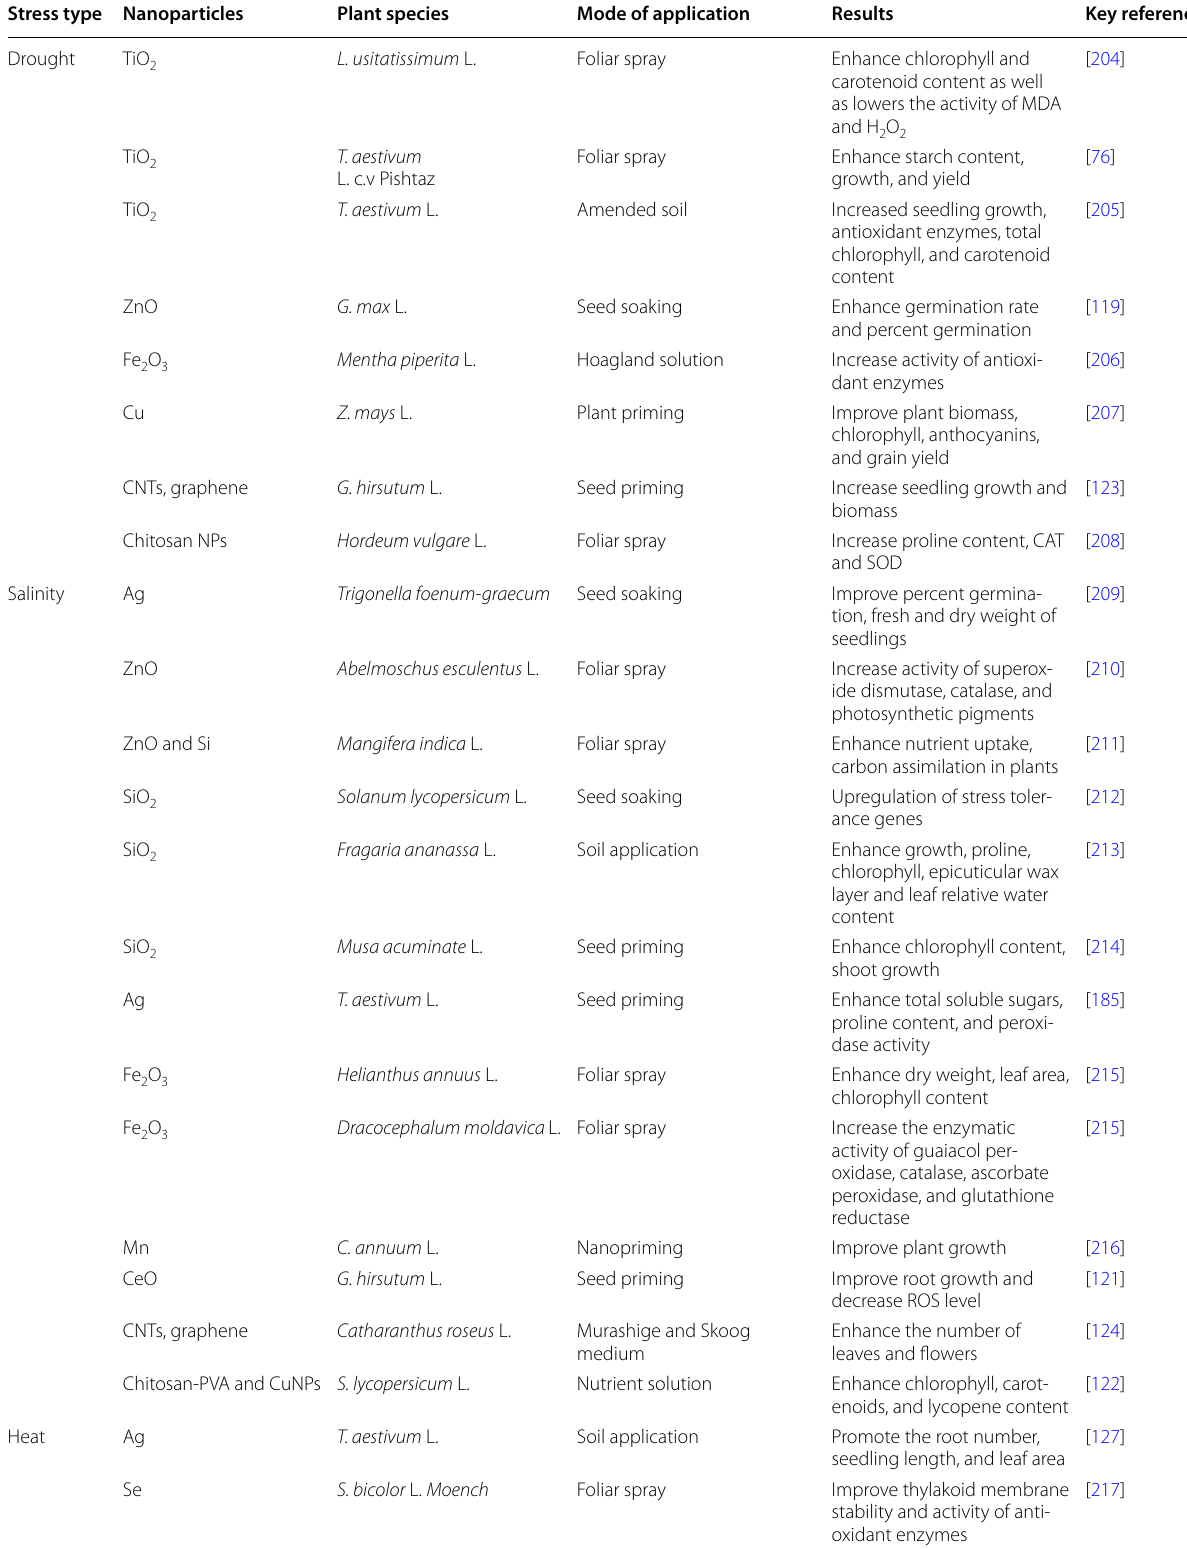
Table 3 Successful application of nanocomposites for abiotic stress tolerance Stress type